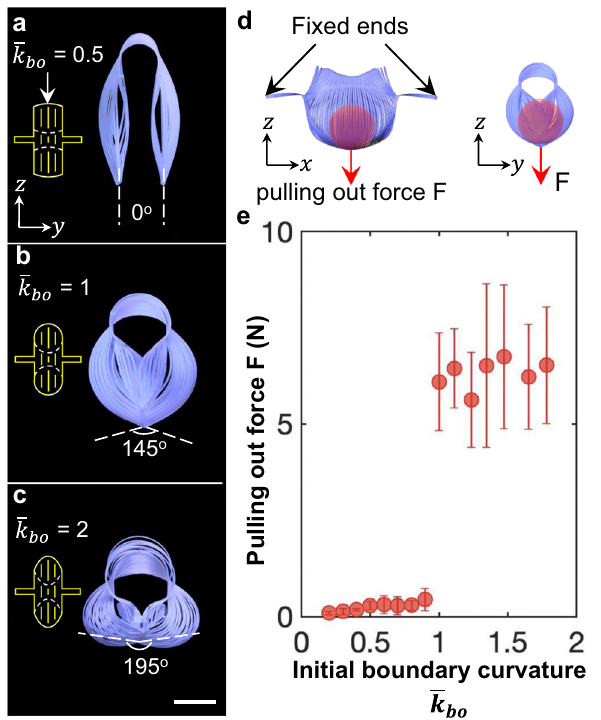
Fig. 7 Effect of the initial boundary curvature on the pulling-out force of kirigami grippers. a – c Experimental illustration of shapes formed by 2D precursors with the different initial-boundary curvatures (cid:1) k bo at the maximum applied strain. The insets show the schematic fi gure of the 2D precursors. The white dashed line represents the angle between the tips of the gripper. d Schematic illustration of measuring the pulling-out force F via pulling out a red sphere from the grippers with various boundary curvatures (cid:1) k bo . Red arrows are the direction of the pulling-out force. e The experimental results on the curve of F vs. (cid:1) k bo . The error bars represent the standard errors of the